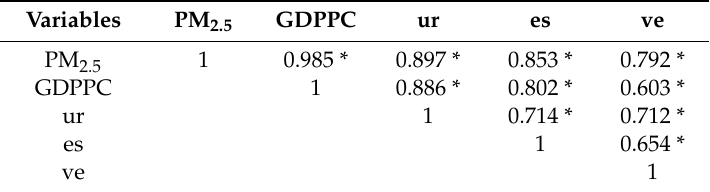
Table 2. Correlations for the panel dataset.